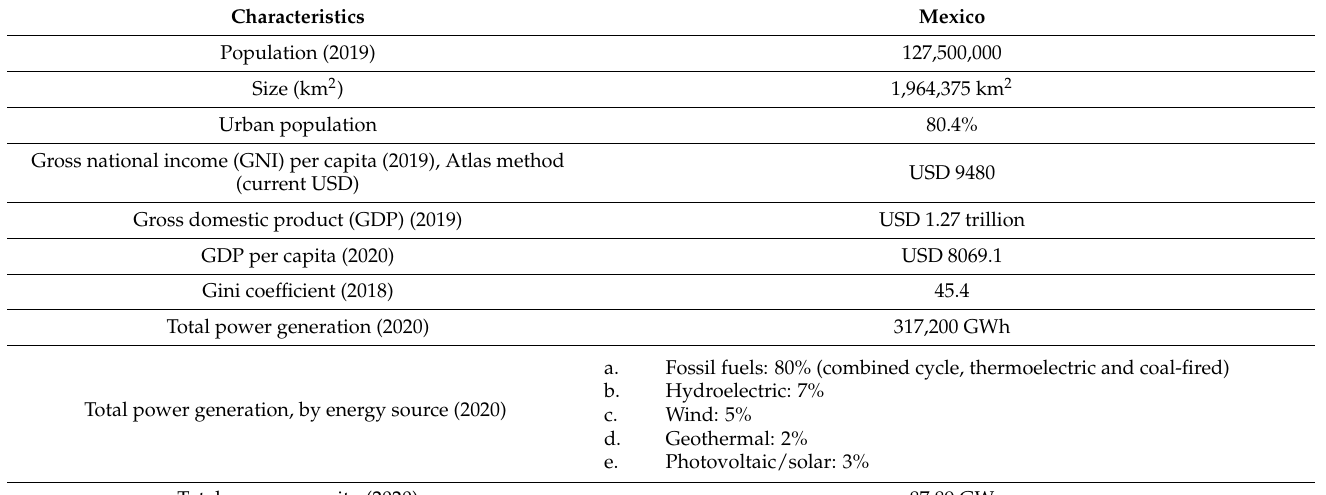
Table 1. Mexican energy